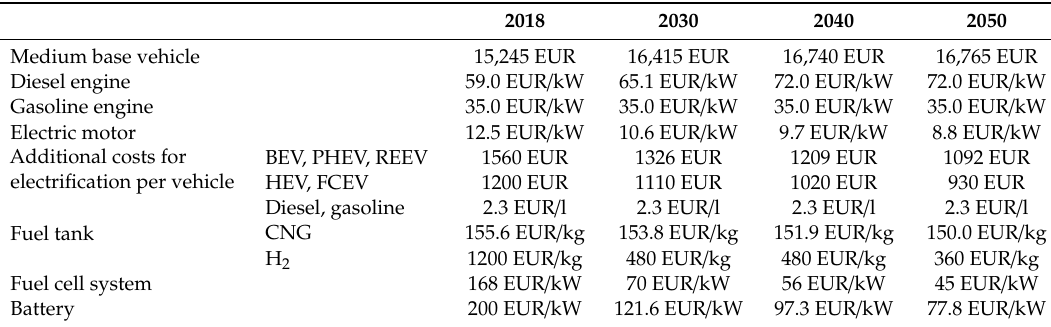
Table A2. Vehicle component cost